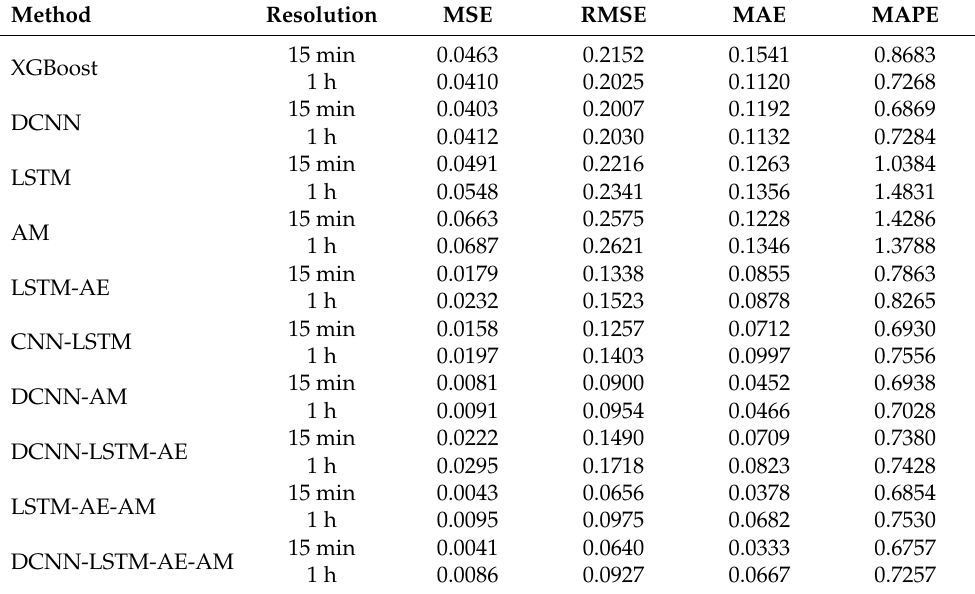
Table 4. Prediction performance comparisons on the SGSC dataset.